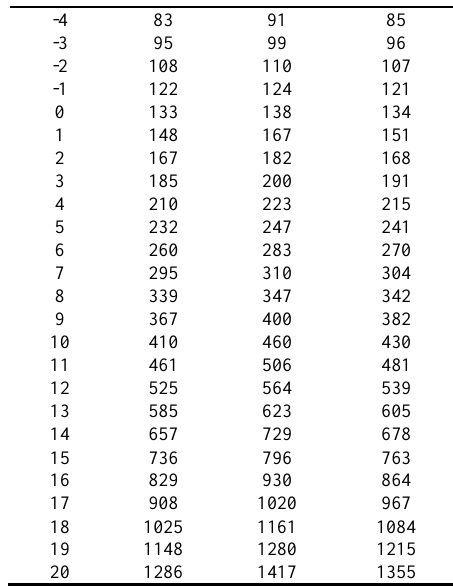
Table 20. Transmission Power vs Distance.